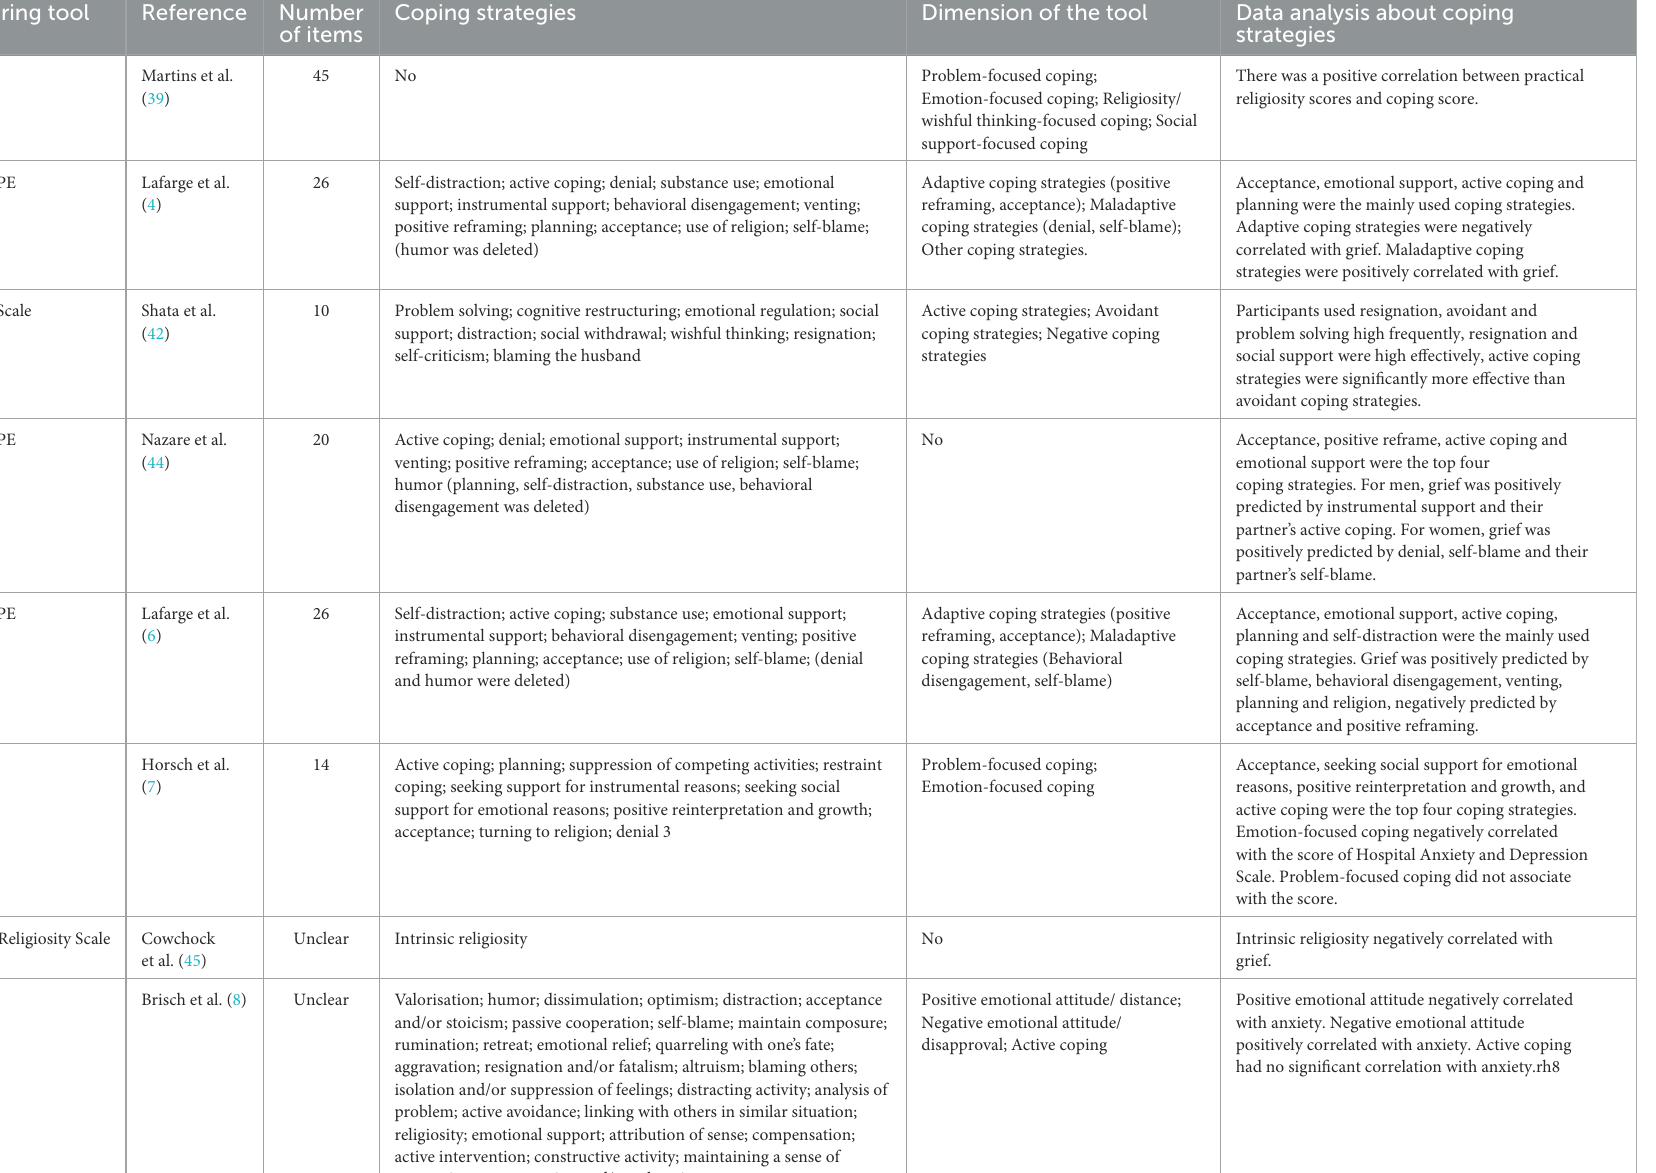
TABLE 4 Description of coping strategies included quantitative studies ( n = 7) and the quantitative part of mixed-method study ( n = 1). Measuring